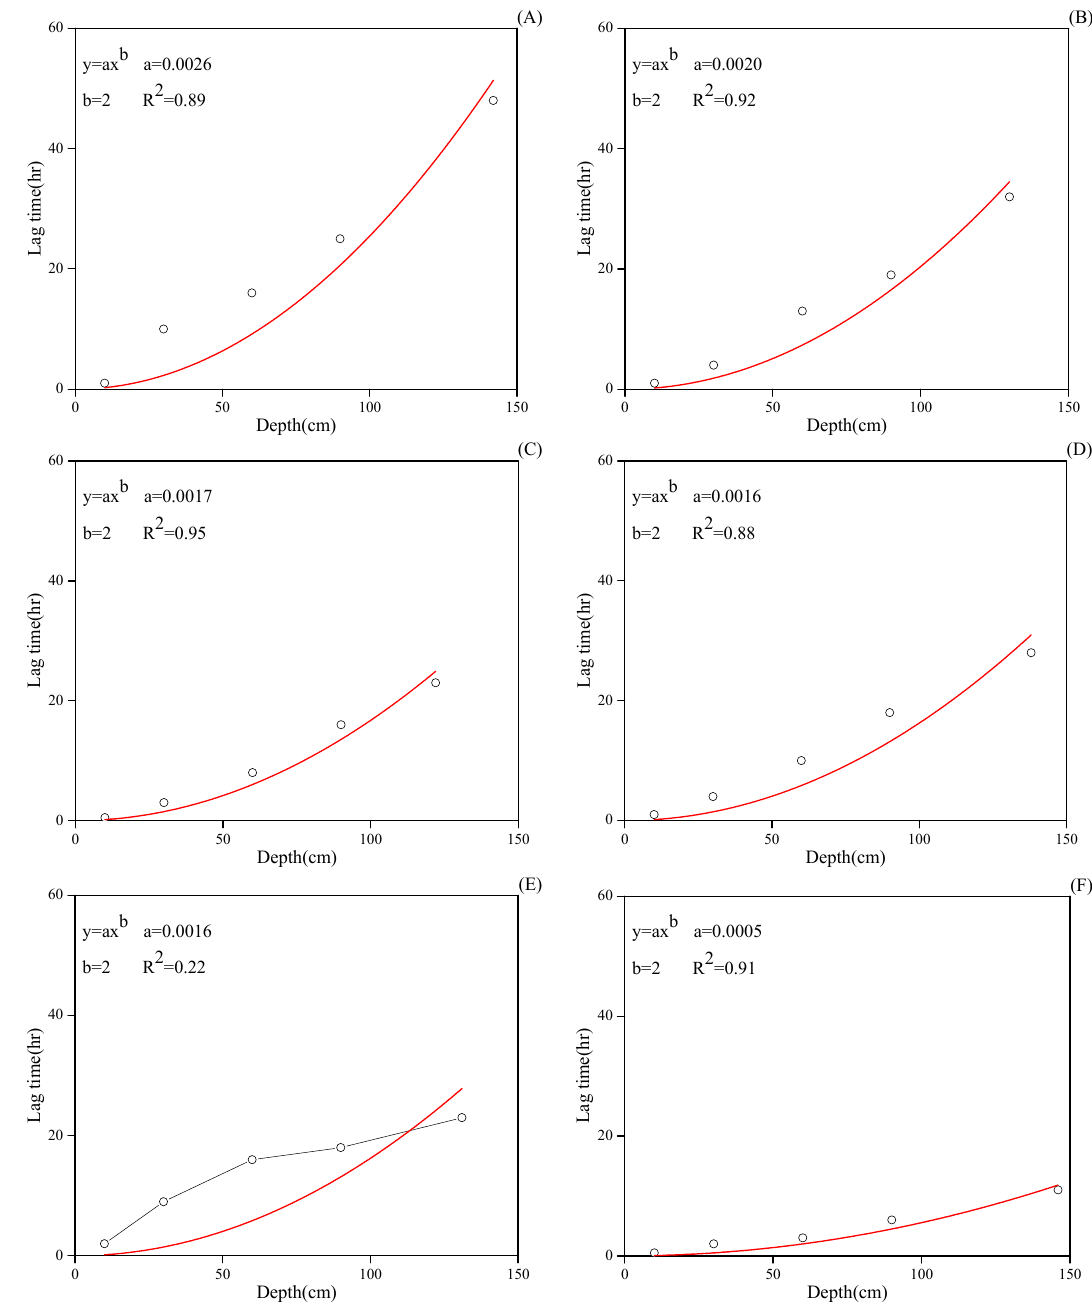
Figure 11. The relationships between the response lag times of water content in the vadose zone and the soil depths for all summer rains leading to water table rising. ( A – F ) means a precipitation of the soil depths for all summer rains leading to water table rising. (A)~(F) means a precipitation of 17.4 mm, 21.2 mm, 22.4 mm, 30.6 mm, 41.4 mm, and 71.6 mm, respectively.